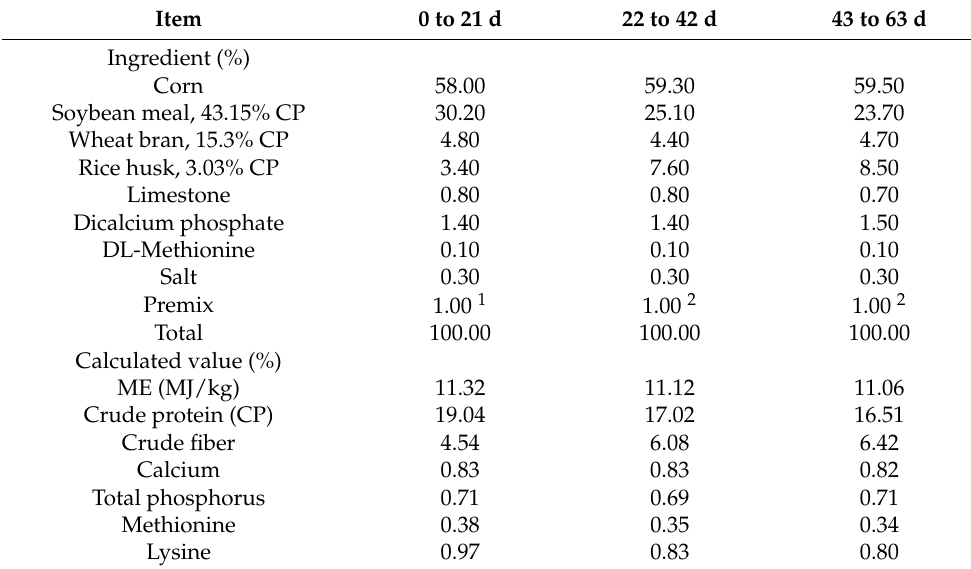
Table 1. Ingredient composition and nutrient content of experimental diets (as-fed